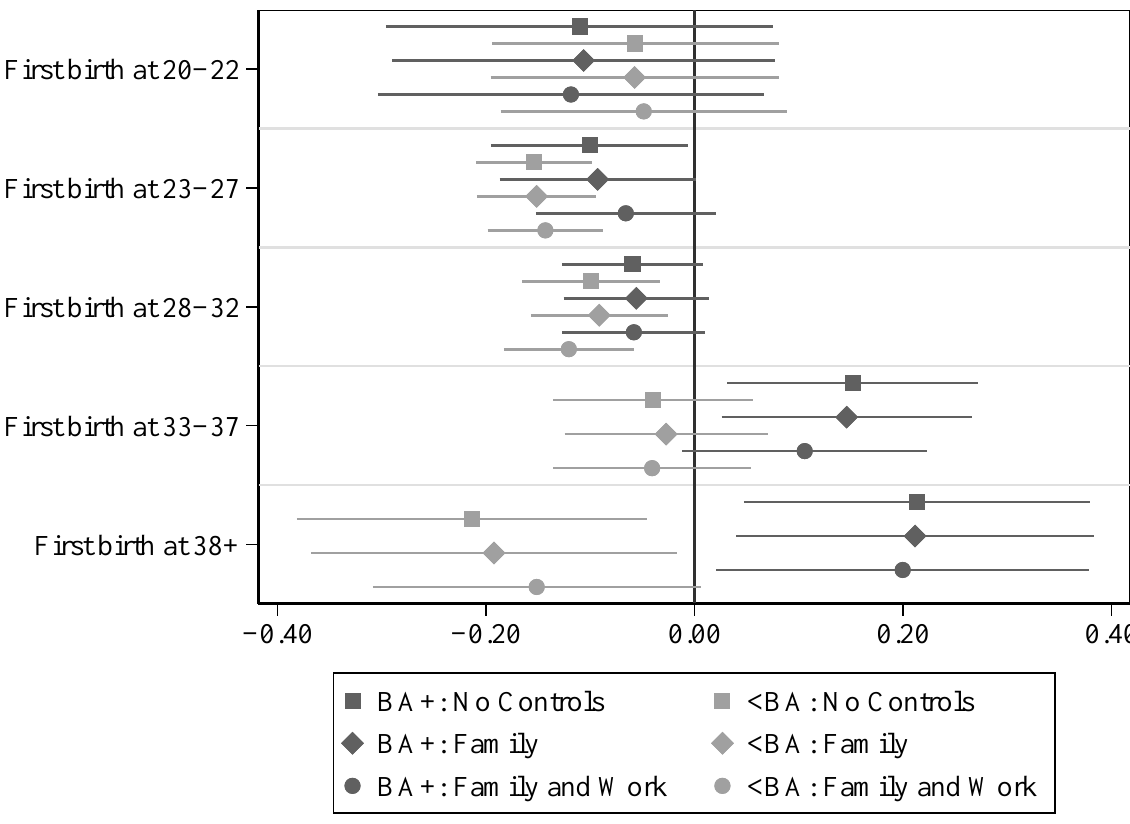
Figure 4: Coefficients across specifications, model 3: timing. Coefficient estimates are from model 3 in Table 2 (“No Controls”), Table 3 (“Family”), and Table 4 (“Family and Work”). BA, bachelor’s